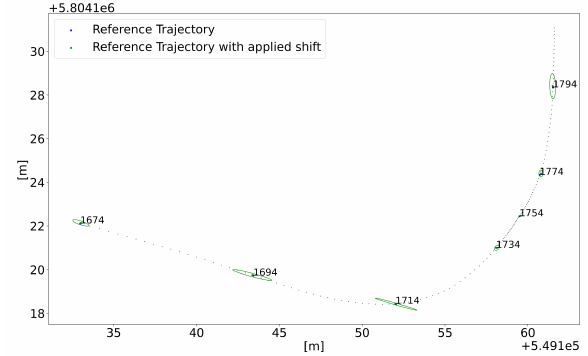
Figure 18. Section of the trajectory along with the positions corrected by the shift according to the highest consensus set and the covariance ellipses of every 20th epoch (ellipses enlarged by a factor of 10).